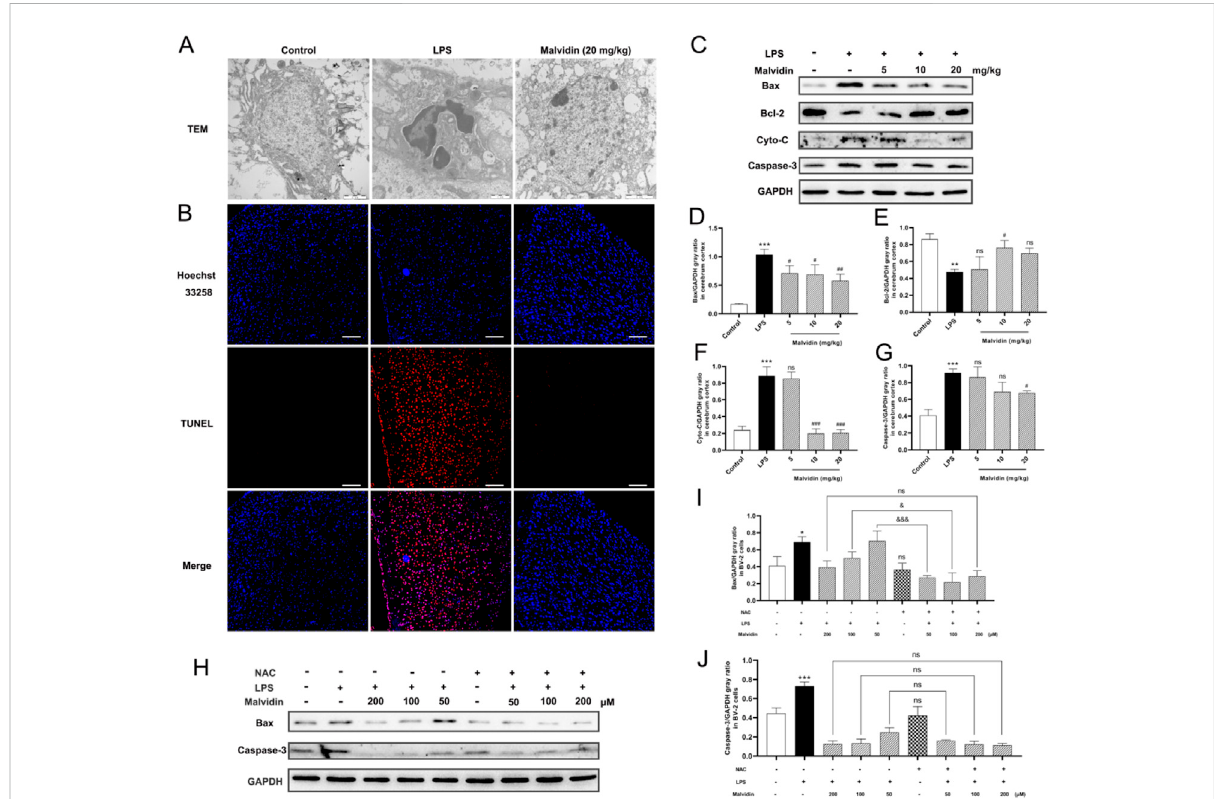
FIGURE 8 Malvidin protects against LPS induced mice cerebrum injury through inhibiting ROS-mediated apoptosis. (A) TEM observation of the microstructures of the nucleus of the cerebral cortex. (B) Tunel staining of apoptosis cells in the cerebrum. Scale bar = 100 µm. The tunnel positive cells were stained in red and nuclear is stained with DAPI (in blue). (C) The expression levels of apoptosis related proteins of Bax, Bcl-2, Cyto-C and caspase-3 in the cerebrum tissues using immunoblotting assays. GAPDH was used as an internal reference. Gray ratio analysis of Bax/GAPDH (D) , Bcl-2/GAPDH (E) , Cyto-C/GAPDH (F) , caspase-3/GAPDH (G) in (C) using ImageJ and excel software ( n = 3). (H) The expression levels of apoptosisrelatedproteinsofBaxandcaspase-3intheBV-2celllysatesusingimmunoblottingassays.GAPDHwasusedasaninternalreference.Gray ratio analysis of Bax/GAPDH (I) , and caspase-3/GAPDH (J) in (H) using ImageJ and excel software ( n = 3). * represents comparison between LPS group and control group, # represents comparison among LPS injection group and malvidin groups or between NAC group and control group, & indicates comparison among malvidin treatment followed by LPS injection groups with or without NAC pretreatment groups. */#/& is p < 0.05, **/## is p < 0.01, ***/###/&&& is p < 0.001, and ns is p >